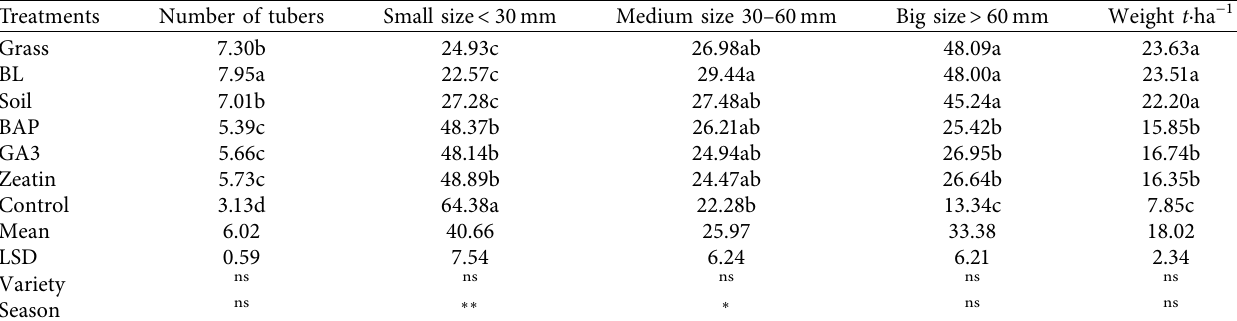
Table 12: Means for tuber yield and the effects of plant growth regulators and natural materials in the 2019–2020 seasons at Molo and Egerton sites.